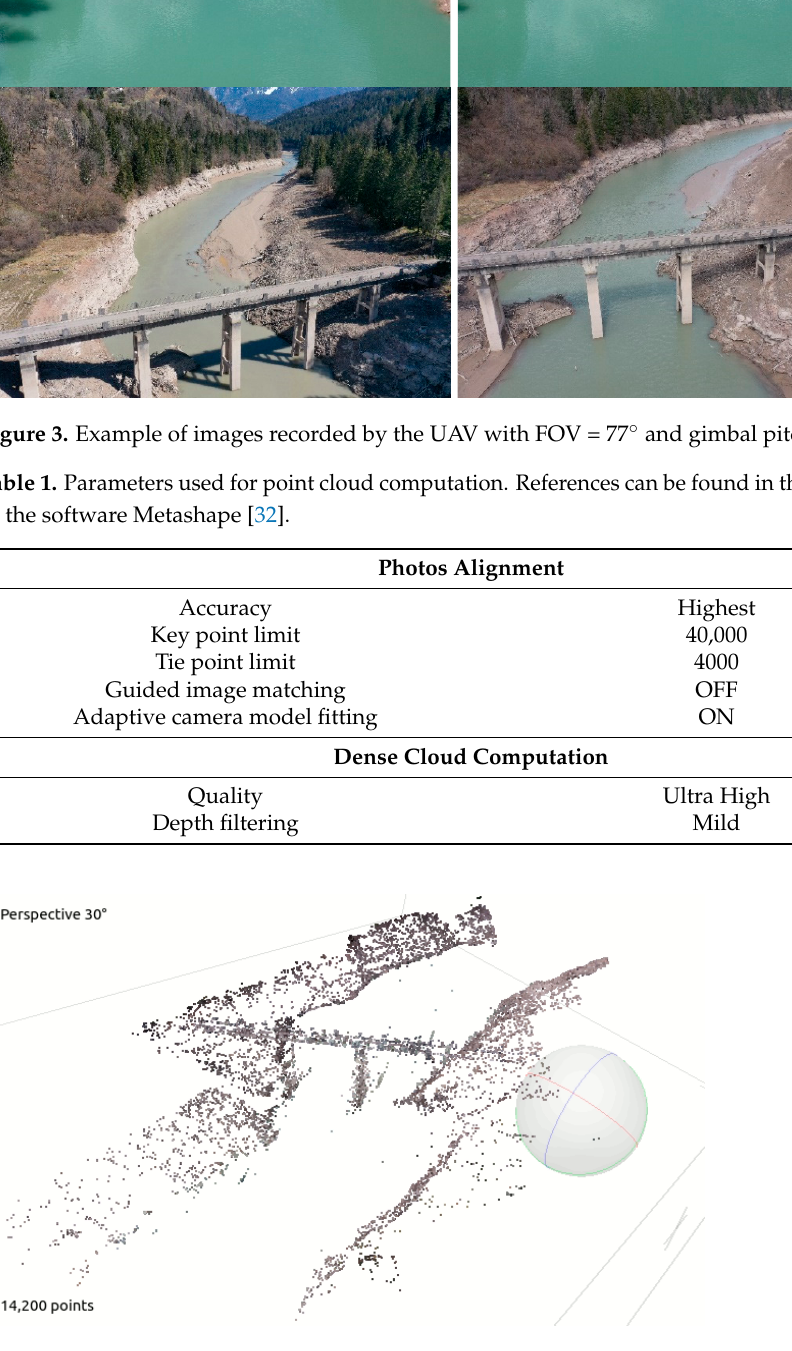
Figure 4. Point cloud obtained from river images collected by the